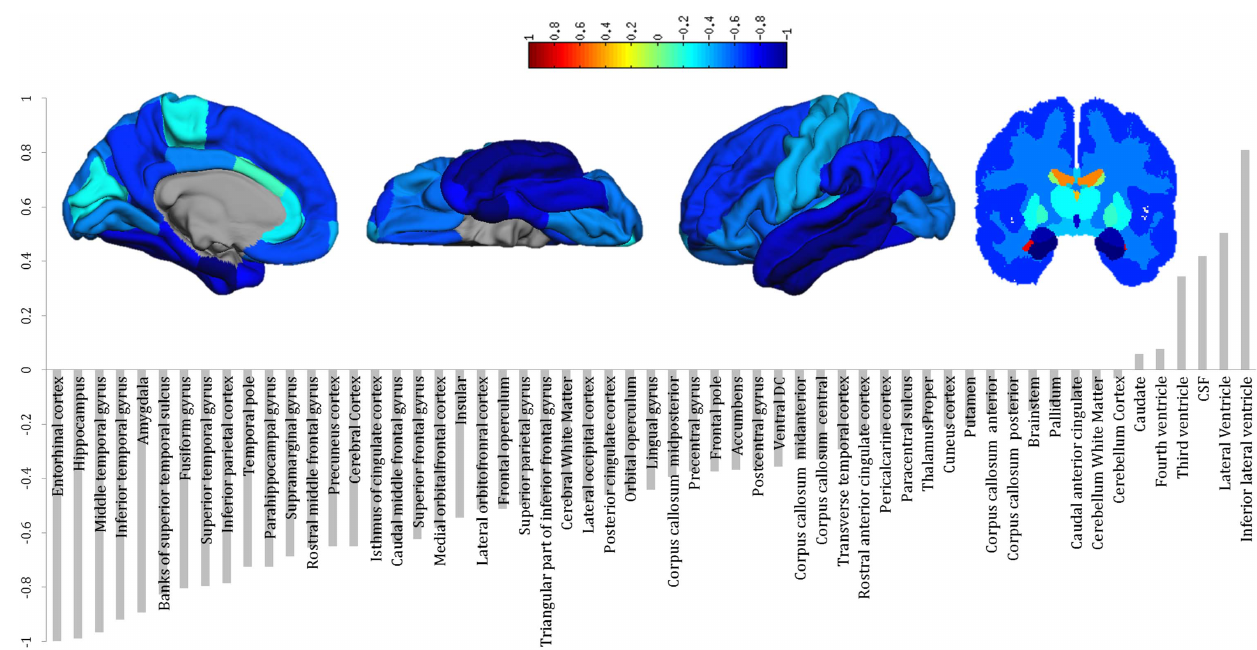
Figure 3. Multivariate discriminative weights computed using ordinal regression. For ordinal regression the weights can be interpreted as the projection of the data along the function space weight vector spanning CTL to MCI-s to MCI-s to AD. Note that the weights are symmetric across hemispheres. These weights are sensitive the spatial correlations in the data and therefore should not be interpreted in a univariate manner.